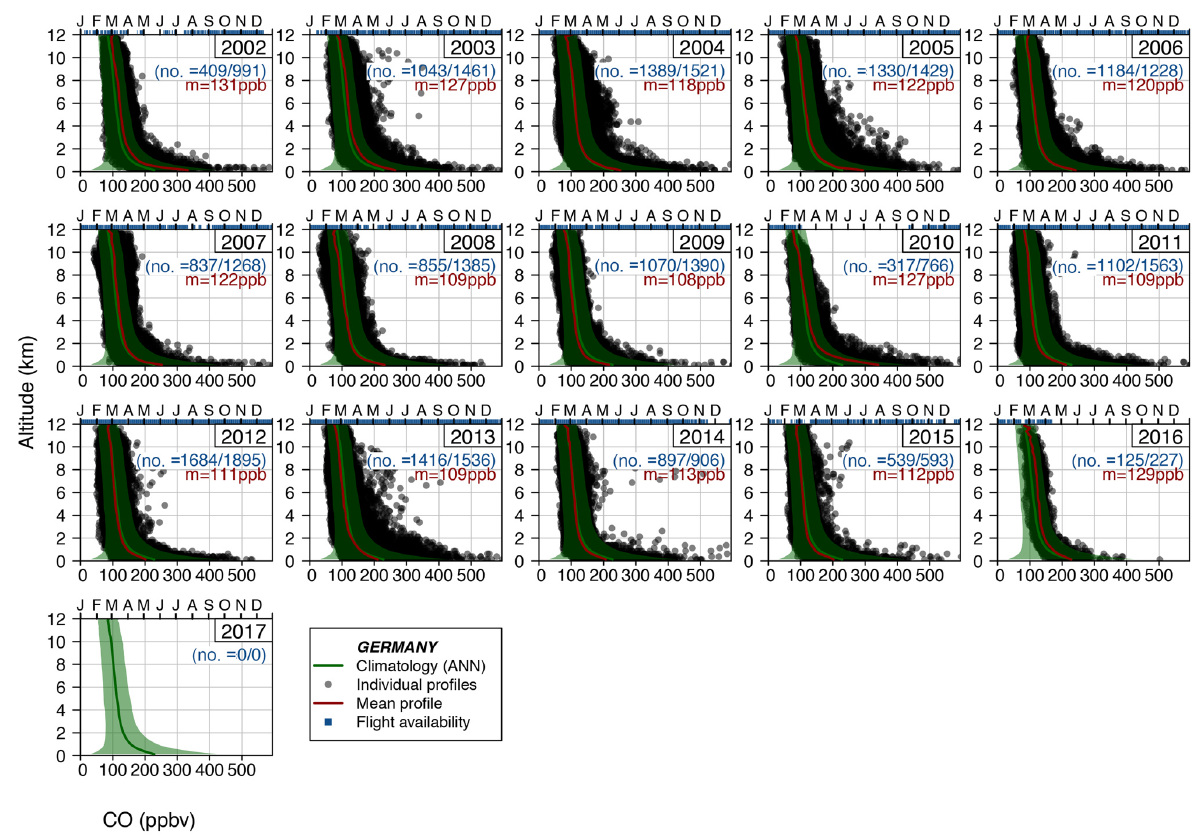
Figure 6. Overview of CO mixing ratio profiles in Germany. All individual CO profiles sampled between 2002 and 2017 are shown with black points (a transparency is added to better highlight the density of points), and the corresponding average profile is shown in red. The mean climatological vertical profile over the period 2002–2017 is shown with a green line (the green area corresponds to ± 2 σ ). The plot also shows in blue the number of vertical profiles and their distribution throughout the year (a blue bar on the time axis above graphs indicates that a flight is available on that day; this time axis does not correspond to the abscissa of the plot). Vertical profiles in 2017 are not yet in a validated status at German airports. The numbers in blue indicate the number of IAGOS profiles with available CO observations and the total number of IAGOS profiles during the considered period. The number in red is the average CO mixing ratio over the entire mean